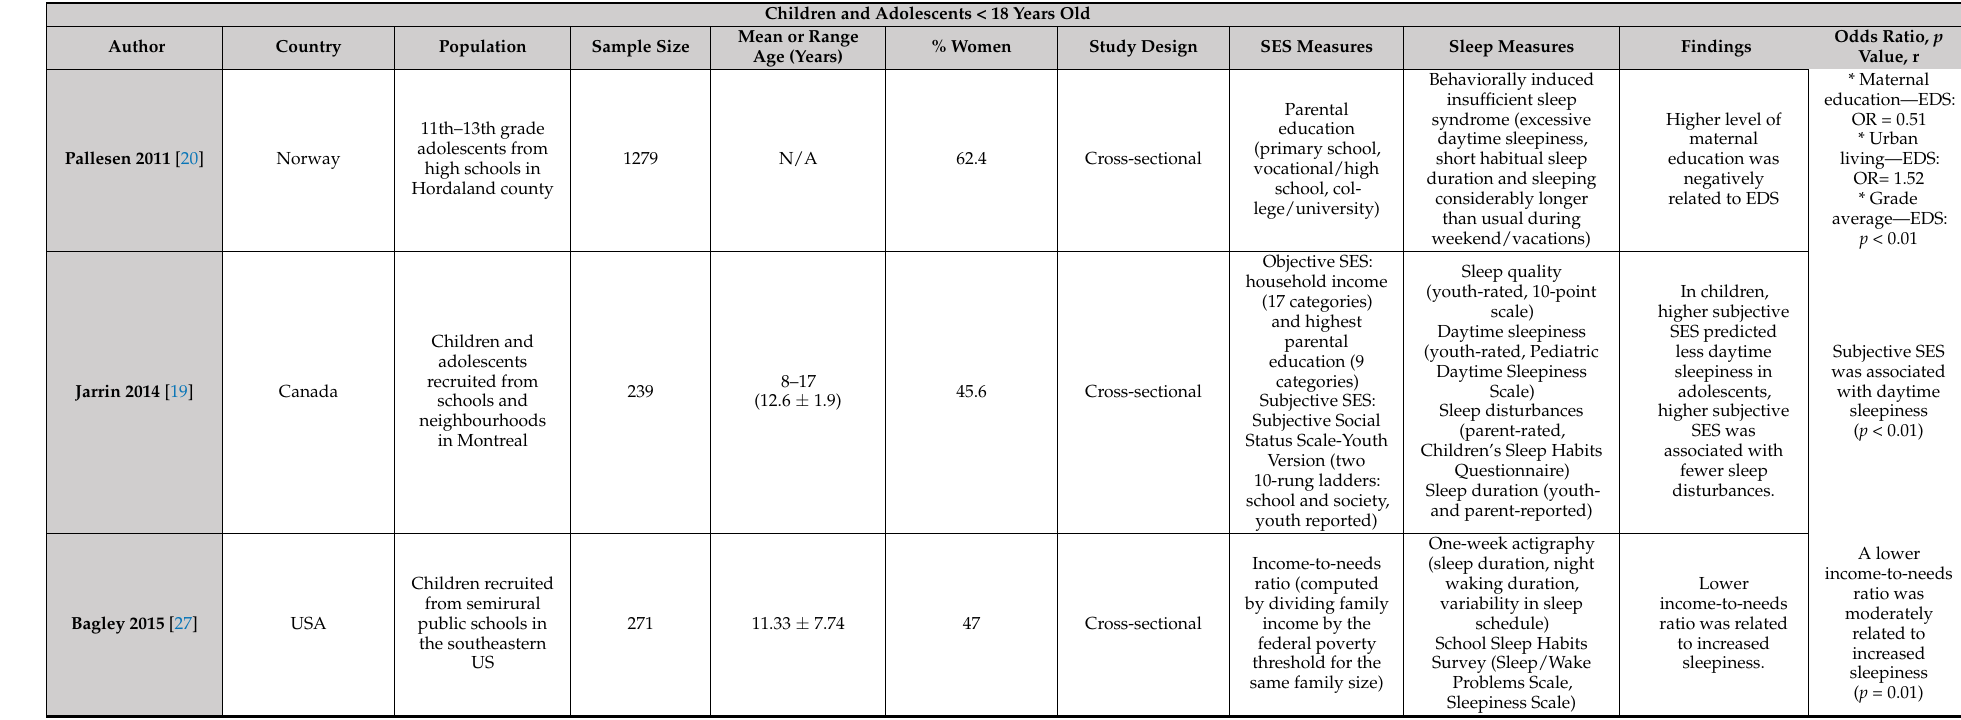
Table 2. Characteristics of included studies investigating the relation between SEP and sleepiness/excessive daytime